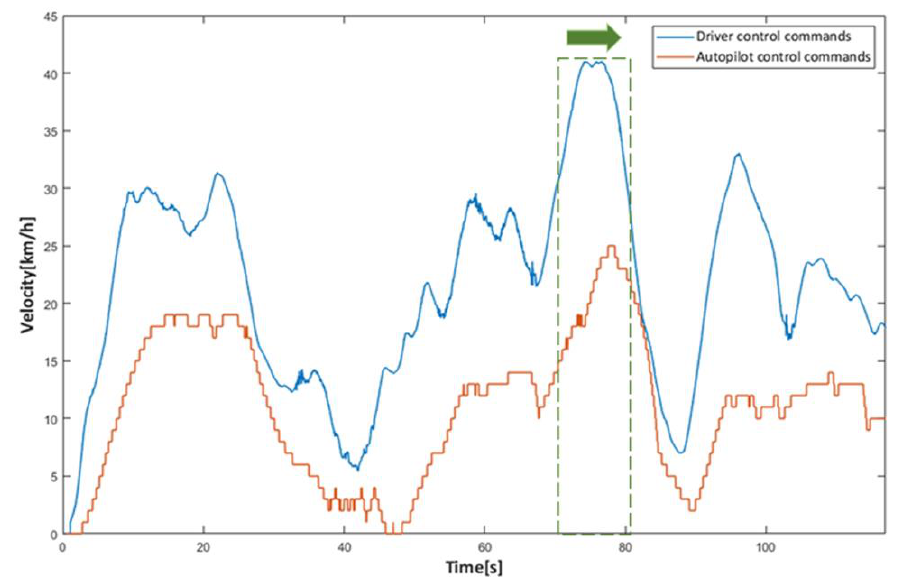
Figure 7. Scroll time